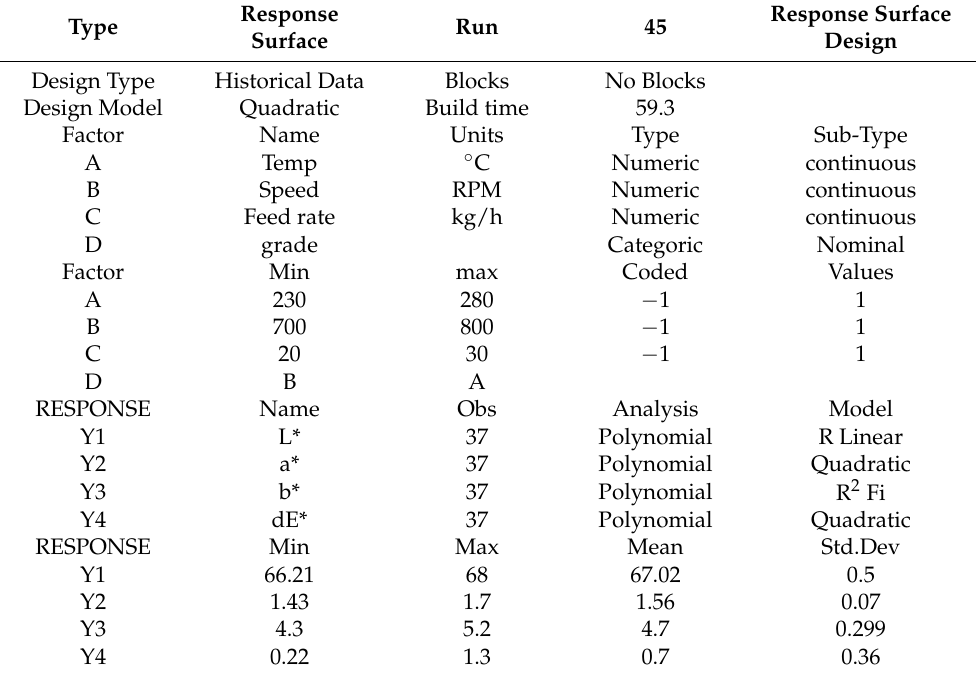
Table 3. Summary of the design